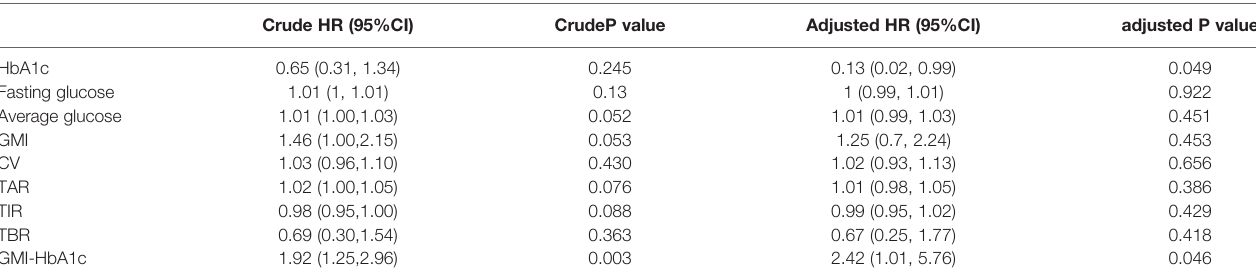
TABLE 5 | Effect of CGM metrics on 28-day mortality